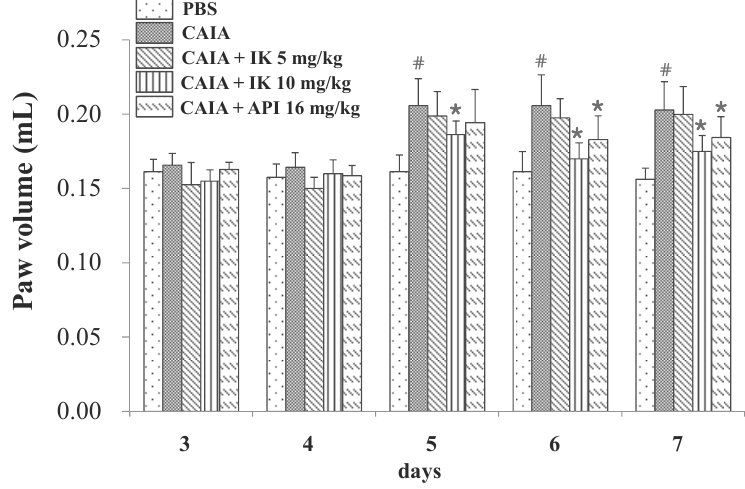
Figure 3. Effect of IK and API on paw volume in CAIA mice. Paw volume were measured using a Digital Plethysmometer every day after lipopolysaccharide (LPS) injection and oral administration of treatments. The average volume of both hind legs was used. Data are presented as means ± SD ( n = 6). # p <0.05 vs. PBS-group and * p <0.05 vs. CAIA-group.